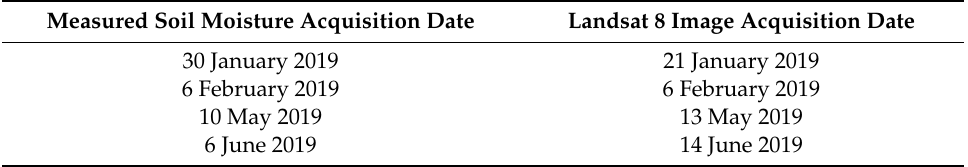
Table 2. Landsat 8 acquisition